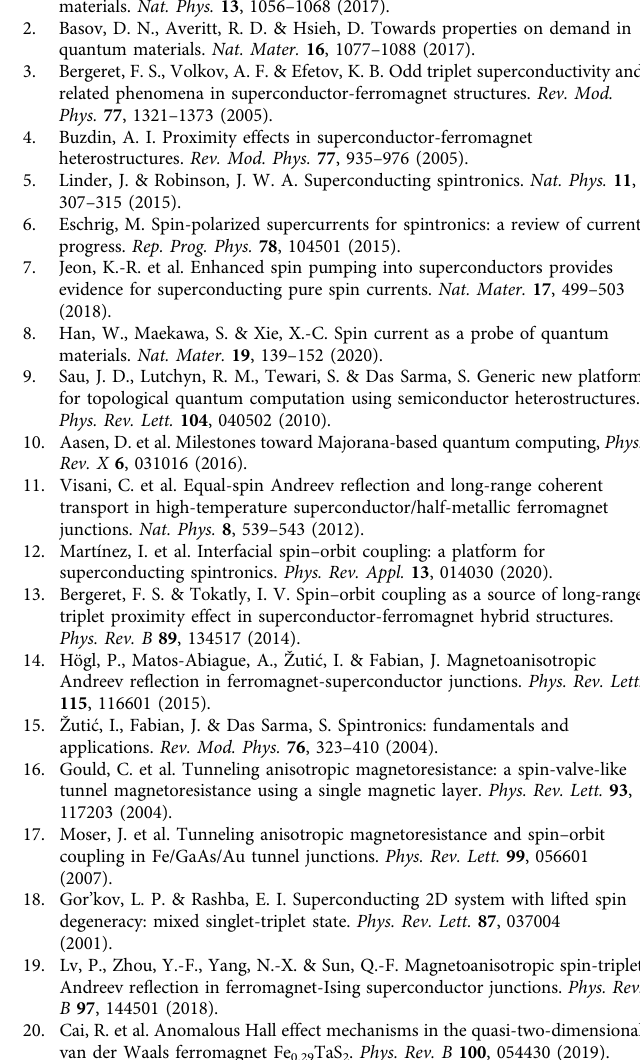
green dots represent the MR of devices A, B, and C, respectively. The error bars correspond to one standard